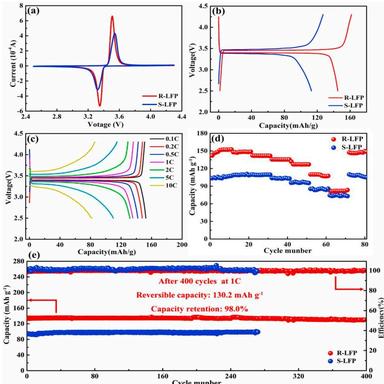
(a) the cyclic voltammetry of R-LFP and S-LFP. (b) The first charge/discharge profiles of R-LFP and S-LFP at 0.2 C. (c) The charge/discharge curves of R-LFP at various rate and (d) the rate capability of R-LFP and S-LFP. (e) The long cycling performance of R-LFP and S-LFP at 1 C.